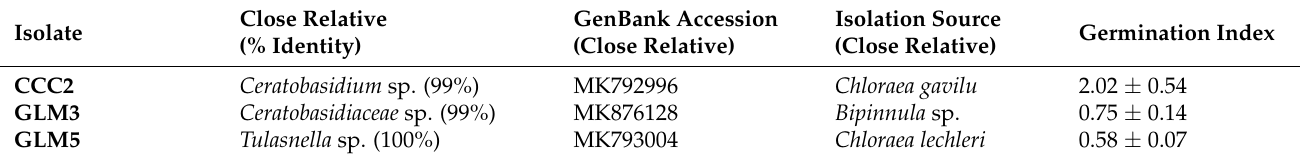
Table 3. Peloton-associated mycorrhizal fungi isolated from a native temperate rainforest in south-central Chile and their effect on the seed germination of the source ( Chloraea collicensis and Gavilea lutea ). Close Relative GenBank Accession Isolation Source Germination Index Isolate (% Identity) (Close Relative) (Close Relative) CCC2 Ceratobasidium sp. (99%) MK792996 Chloraea gavilu 2.02 ± 0.54 GLM3 Ceratobasidiaceae sp. (99%) MK876128 Bipinnula sp. 0.75 ± 0.14 GLM5 Tulasnella sp. (100%) MK793004 Chloraea